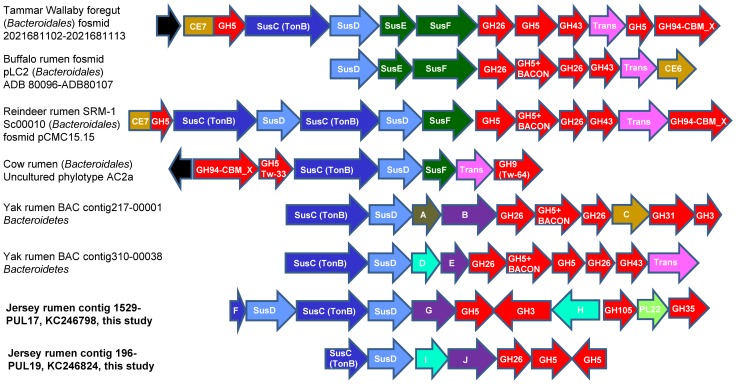
Gene organization of representative cellulolytic PULs identified in available metagenomes and the present study (shown in bold).The genes of the two PULs identified in this study were listed in Table S4. The figure was partly adapted from the paper by Pope et al
[5]. Consistent with that paper, black genes represent putative response-regulators. SusE/SusF-like genes encode outer-membrane proteins. Trans: putative transporter. BACON: a carbohydrate binding domain. TonB: TonB-dependent receptor family, which functions to transport solutes and macromolecules with a membrane spanning β-barrel proteins. TW-64 and TW-33 are sample IDs for the GH9 and GH5 genes (respectively) identified within the AC2a PUL. GenBank accession numbers and/or IMG Gene Object ID numbers are provided for each cluster/scaffold when available, and details for each gene were listed in Table S6. A: hypothetical lipoprotein; B, E, G, J: putative polygalacturonase; C: sialic acid acetylesterase; D, H, I, hypothetical protein; F: SusC homolog. Both F and the first SusC in contig 196-PUL19 are located at the end of the contigs.